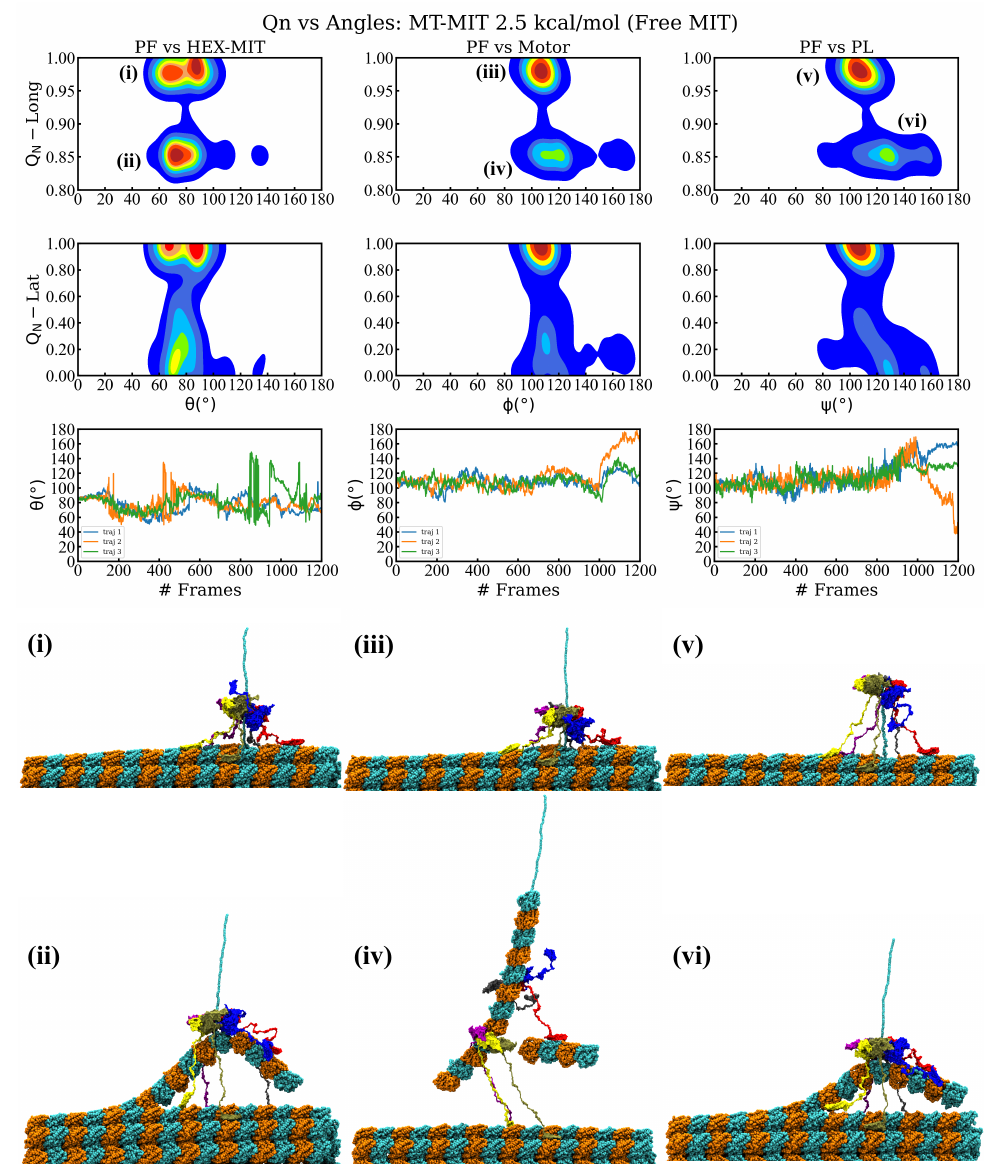
Figure 3. Results of the spastin machine acting on a MT filament for the interaction strength between its MIT domains and the MT lattice set to 2.5 kcal/mol. ( Top ) row plots show the free energy landscape in the plane of the fractional loss of longitudinal native contacts (Q N ) of the pulled protofilament (PF6) and the angle made by the principal axis of the severing enzyme (HEX-MIT), of the motor, and of the central pore loops (PL), respectively, versus the long axis of the pulled PF (PF). ( Middle ) row plots show the free energy landscape in the plane of the fractional loss of lateral native contacts of the pulled protofilament and the three angles from the top row panels. The lowest row plots depict the time evolution of the three angles from the upper plots versus the simulation frames. Instantaneous snapshots of the representative structures corresponding to the labeled minima in the free energy plots are shown at the ( Bottom